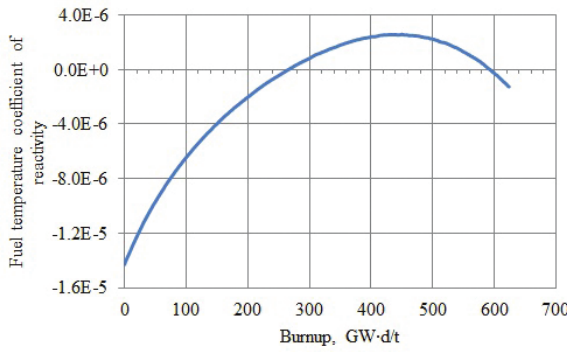
Figure 5. Changes in the fuel temperature coefficient of reactivity during the campaign of fuel containing 44% of 235 U + 56% of 231